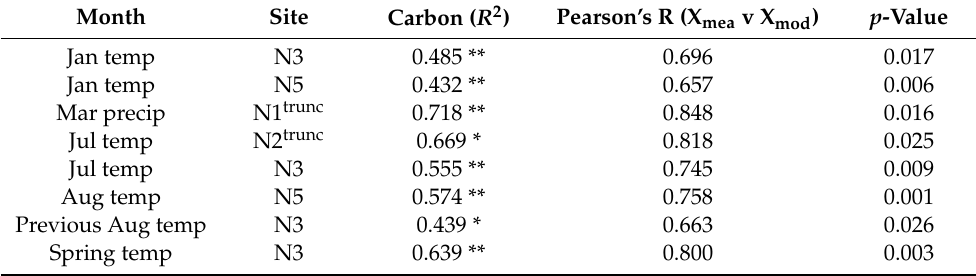
Table 4. R 2 values from the regression analysis of percent carbon on total monthly precipitation (mm) (Precip) and average monthly temperature ( ◦ C) (Temp) for the natural stands surrounding John